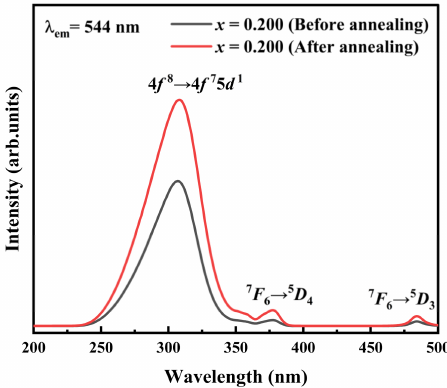
Figure 10. Excitation spectra of (ZrO 2 ) 92 (Y 2 O 3 ) 7.800 (Tb 4 O 7 ) 0.200 crystals before and after annealing at 1500 ◦ C in a H 2 /Ar atmosphere monitored at 544